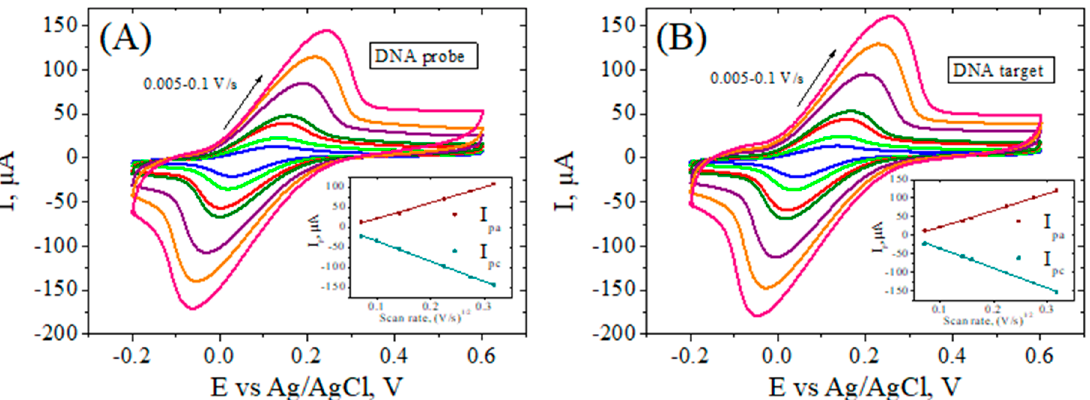
Figure 7. CV curves of ssDNAp/Ar–COOH/RGO/SPCE ( A ), and ssDNAp/Ar–COOH/RGO/SPCE after hybridization with DNA target ( B ) recorded at different scan rates in 1 mM [Fe(CN) 6 ] 3 − /4 − , 0.1 M KCl solution. Inset: plot of anodic and cathodic peaks vs. square root of scan